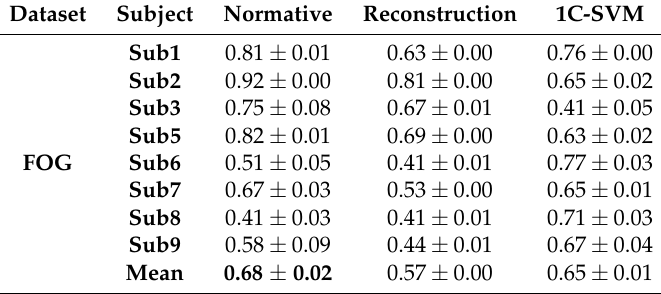
Table 4. The average of AUC results for novelty detection using normative modeling, reconstruction-based and one-class-SVM trained only on the two available normal subjects (Subjects 4 and 10) of the FOG dataset.